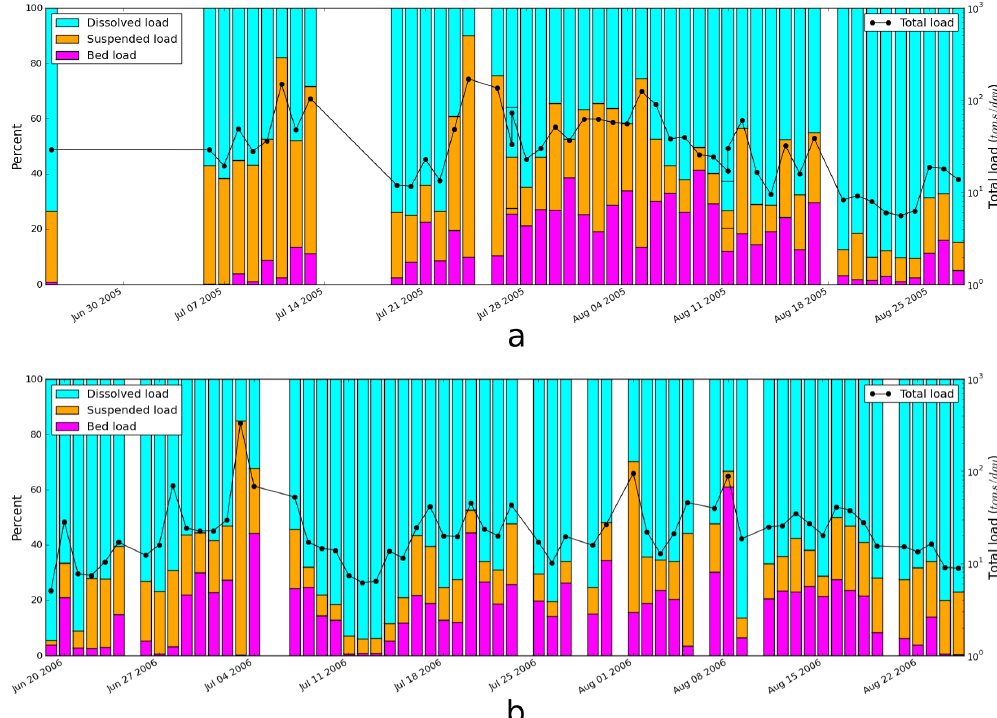
Fig. 7. Mass flux balance: (a) Total flux of mass both dissolved and solid measured in the Urumqi River during the summer of 2005 together with the proportion of dissolved load, suspended load and bed load (coloured cumulative histograms). (b) Same for 2006.